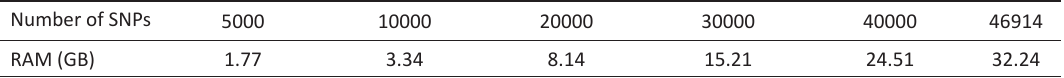
Table 6. Peak RAM use (in GB) for 19757 individuals and an increasing number of SNPs (5000 to 46914) Number of SNPs 5000 RAM (GB)